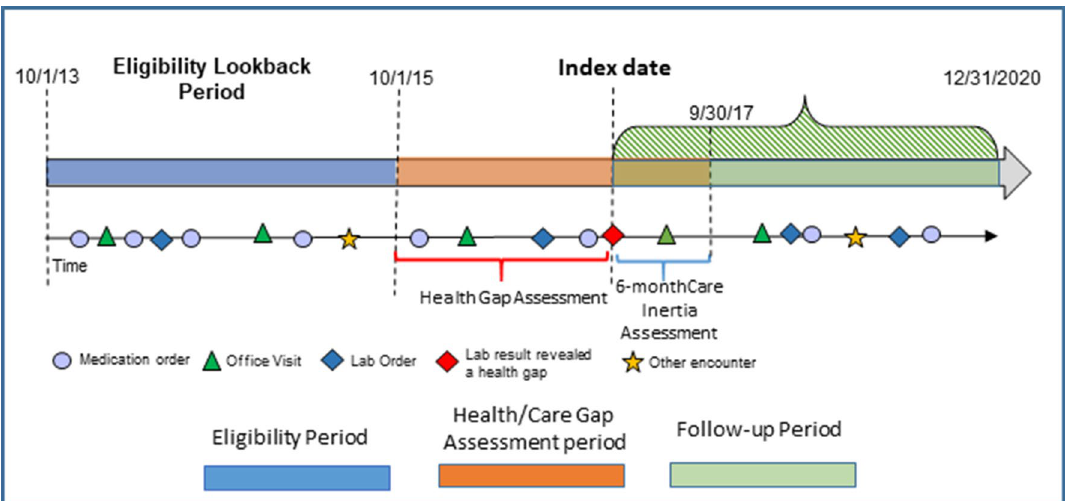
Figure 2. Retrospective use of EHR data to identify eligible primary care patients, health gaps, clinical inertia and follow-up period. Study eligibility criteria timeline depicting how primary care patients, health gaps, clinical inertia and follow up period were identified